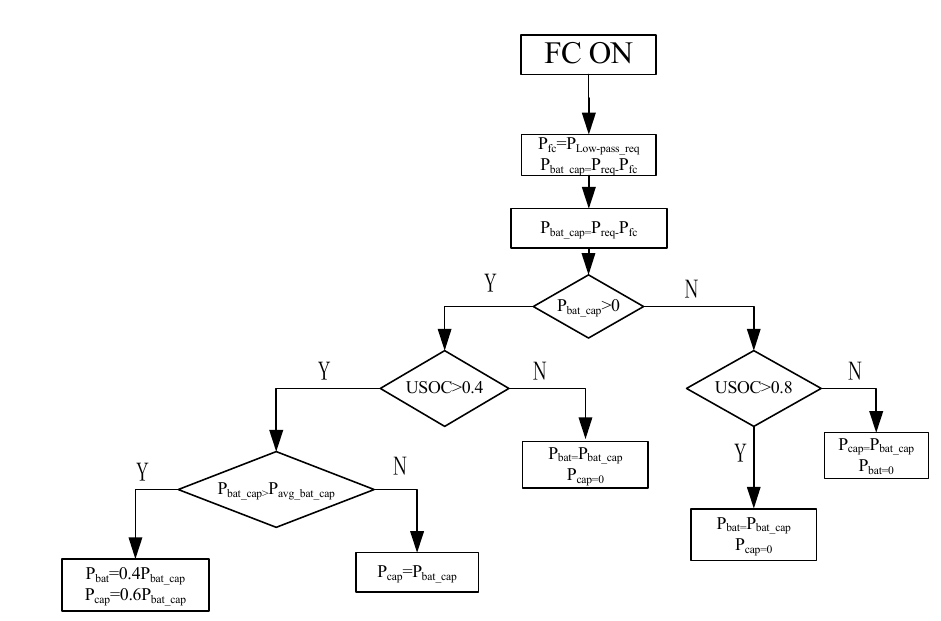
Figure 9. Flowchart of rules for energy management when the fuel cell is on.